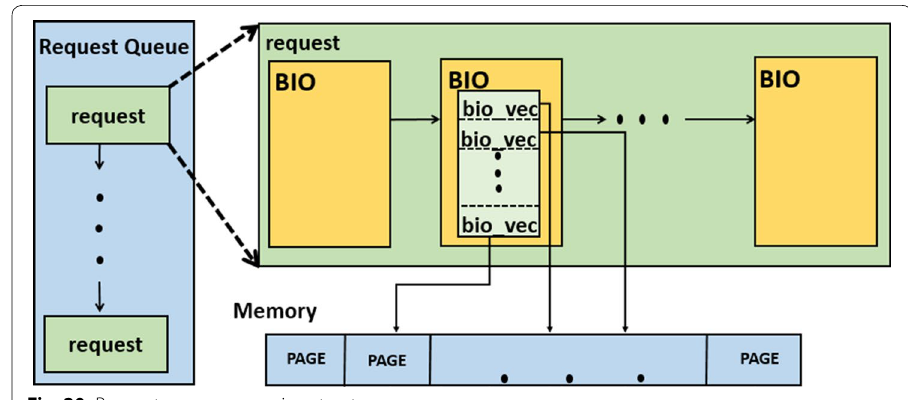
Fig. 20 Request queue processing